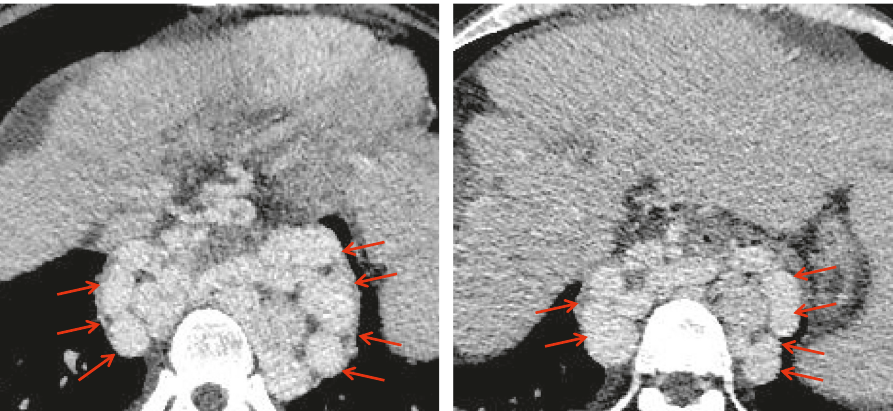
Figure 4: Paraesophageal varices. In a 37-year-old male with liver cirrhosis, the axial contrast-enhanced CTscan on the portal vein phase demonstrated that paraesophageal varices (red arrow) were tortuous vessels outside the esophageal wall.